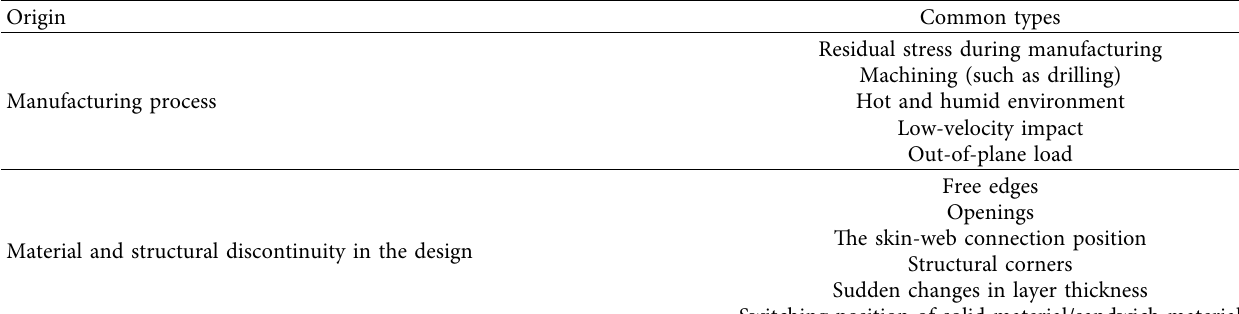
Table 2: Common factors causing delamination damage of FMLs.